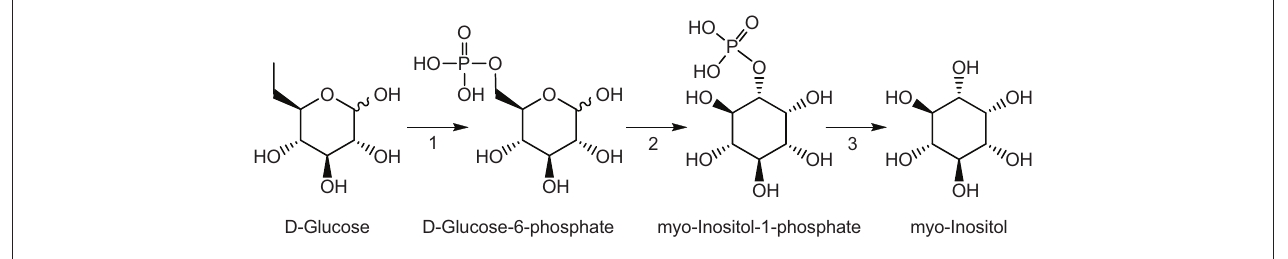
FigURe 6 | Myoinositol pathway in plants. 1, hexokinase; 2, myoinositol-1-phosphate synthase;